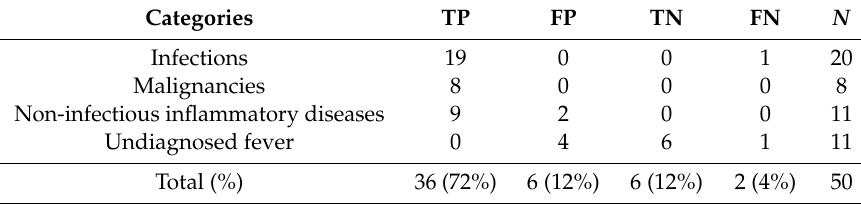
Table 4. 18 F-FDG-PET / CT scan results according to the category of final diagnosis.